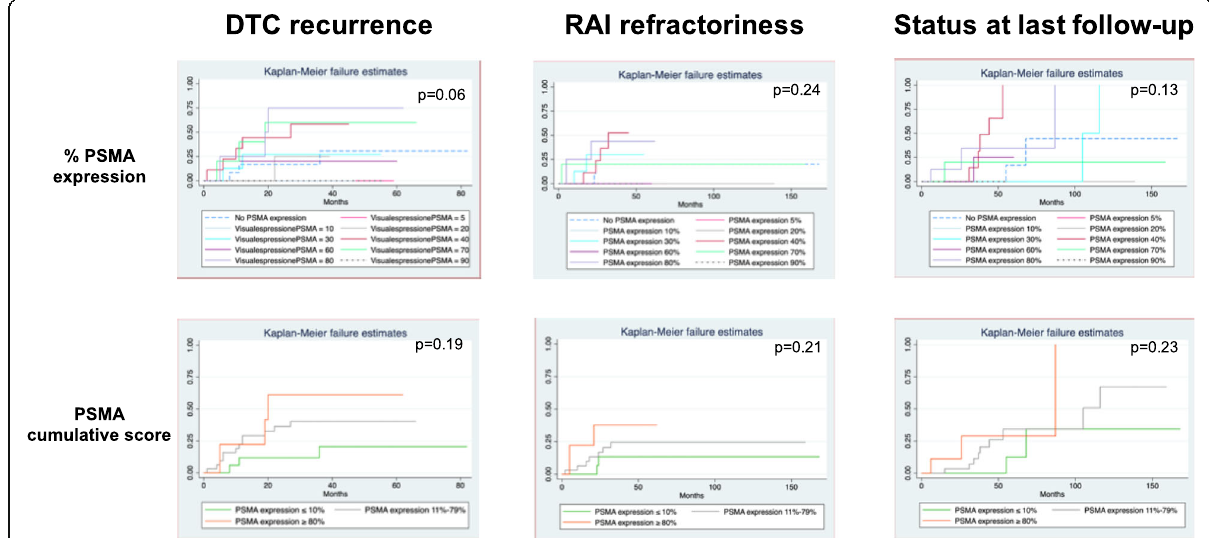
Fig. 2 Kaplan-Meier curves and univariate analysis results in relation to PSMA immunoreactivity and